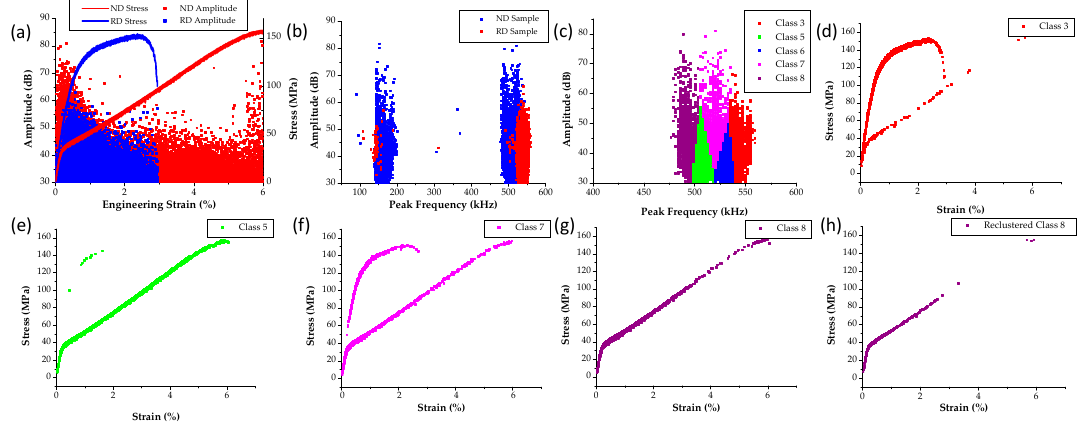
Figure 12. ( a ) Stress-strain curves and amplitude plot of ND and RD test samples at the MTS level; ( b ) frequency amplitude plot of both samples; ( c ) K-Means class distribution of data with peak frequency between 400 and 600 kHz; ( d – g ): class 3, 5, 7, 8 AE hits; ( h ) reclustered class 8 AE hits.